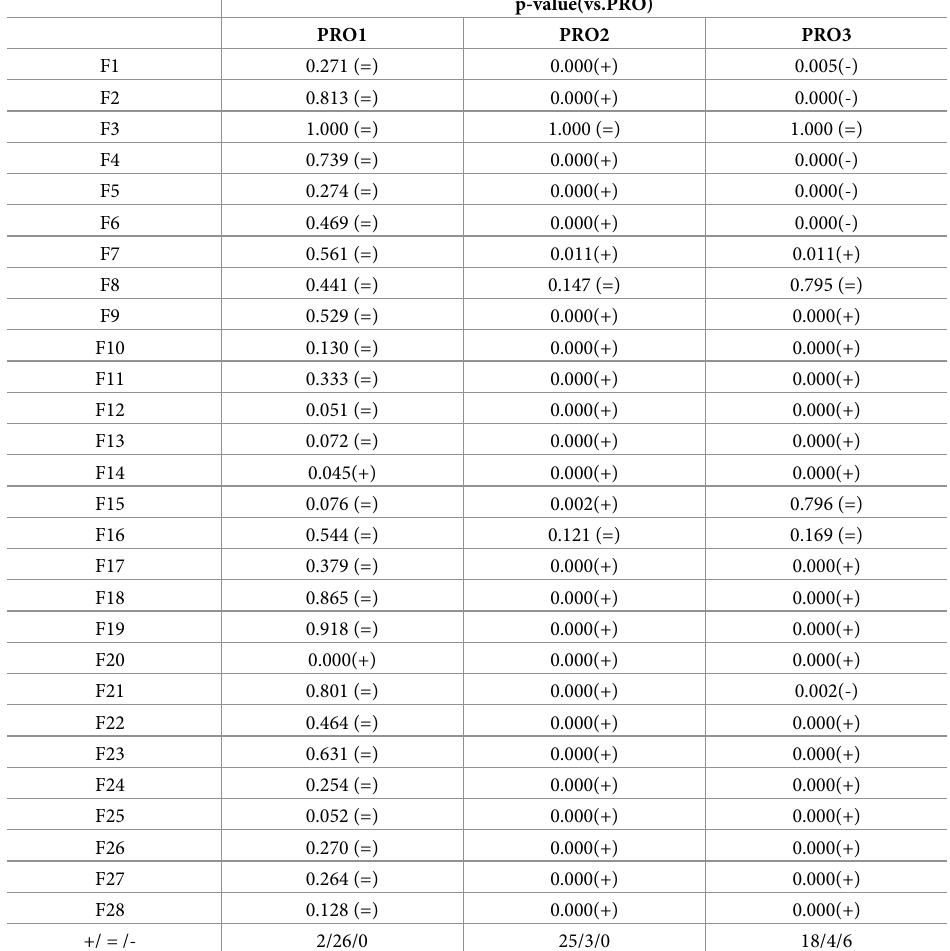
Table 4. Wilcoxon rank sum test between PRO and each improved